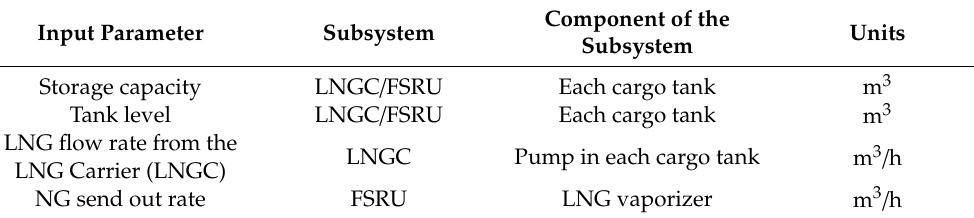
Table 1. Parameters used in the simulation